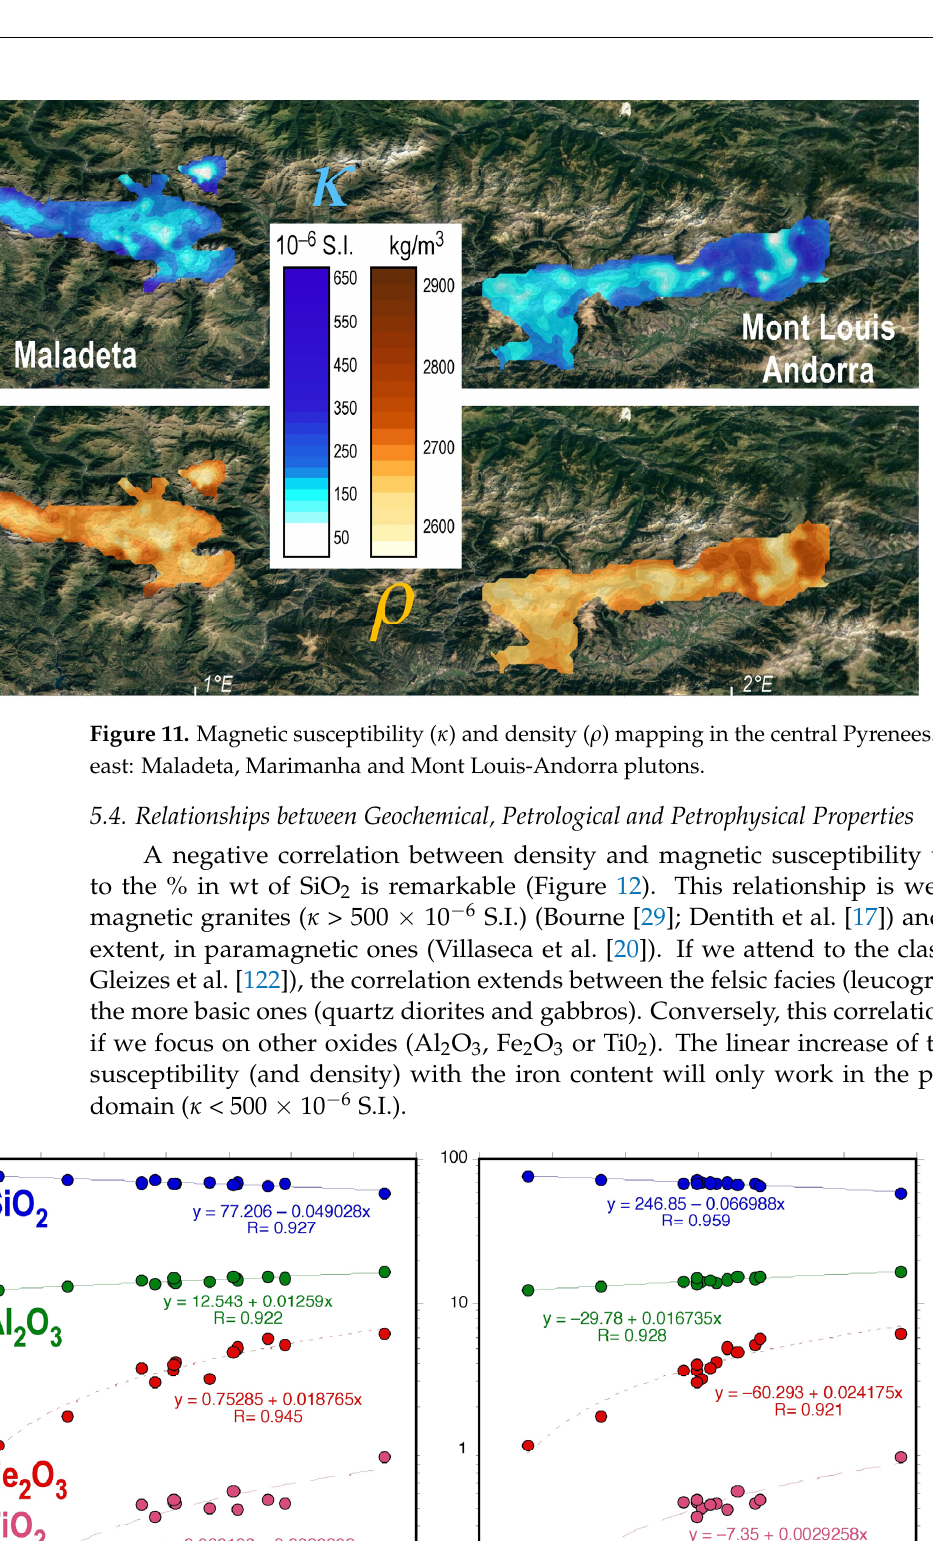
Figure 13. ( A ) Histogram of the magnetic susceptibility (site means) and density data in the Pyre- nees (derived from the AMS database). ( B ) mean magnetic susceptibility vs. granite body size (km 2 ). 5.5. The Pyrenean Petrophysical Database of Granites Finally, we can tentatively extend the robust linear regression found in the Maladeta, Marimanha and Mont Louis-Andorra granites (Equation (3)) to the entire AMS Pyrenean database (Porquet et al. [43] and references therein). It is worth mentioning that, ideally,